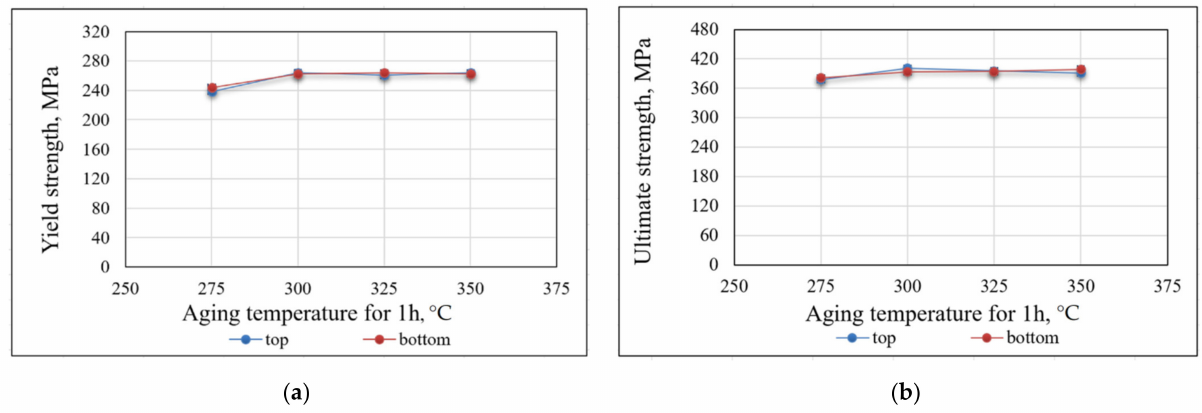
Figure 9. Mechanical properties of specimens, aged at various temperatures for 1 h: ( a ) yield strength; ( b ) ultimate